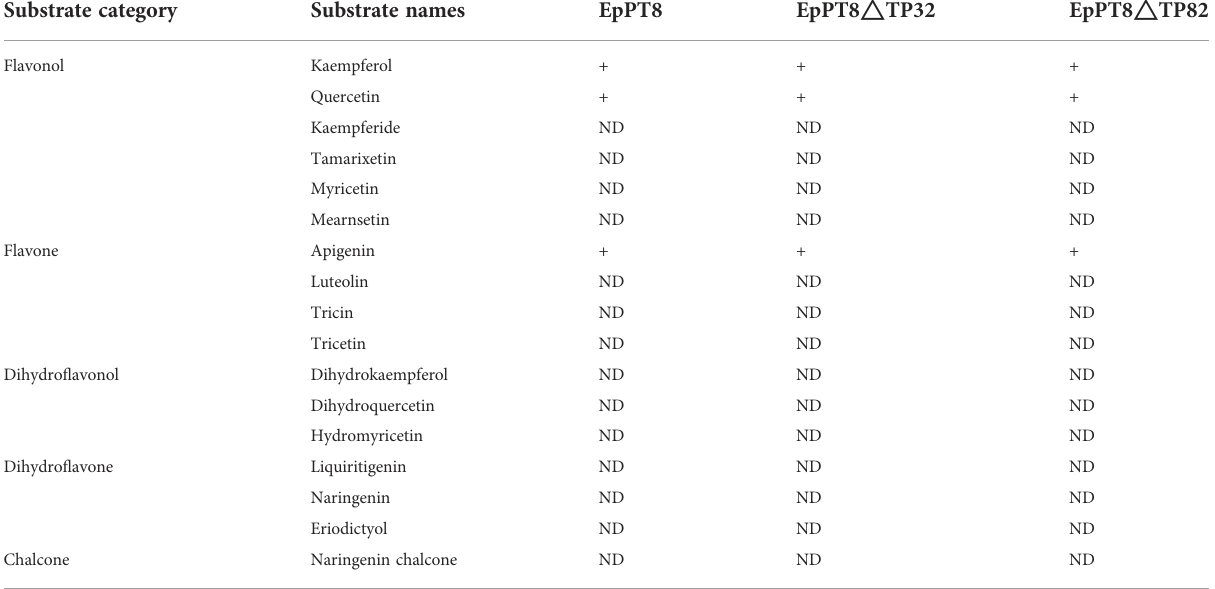
TABLE 3 Results of enzymatic